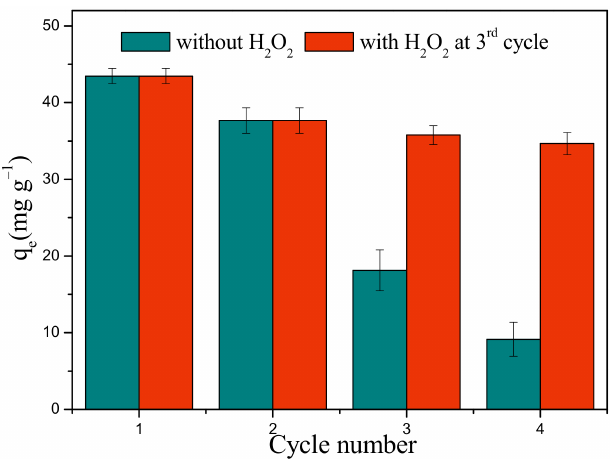
Figure 8. Cycling runs for the degradation of MB (40 mg L − 1 ,100 mL) over Fe/NG.